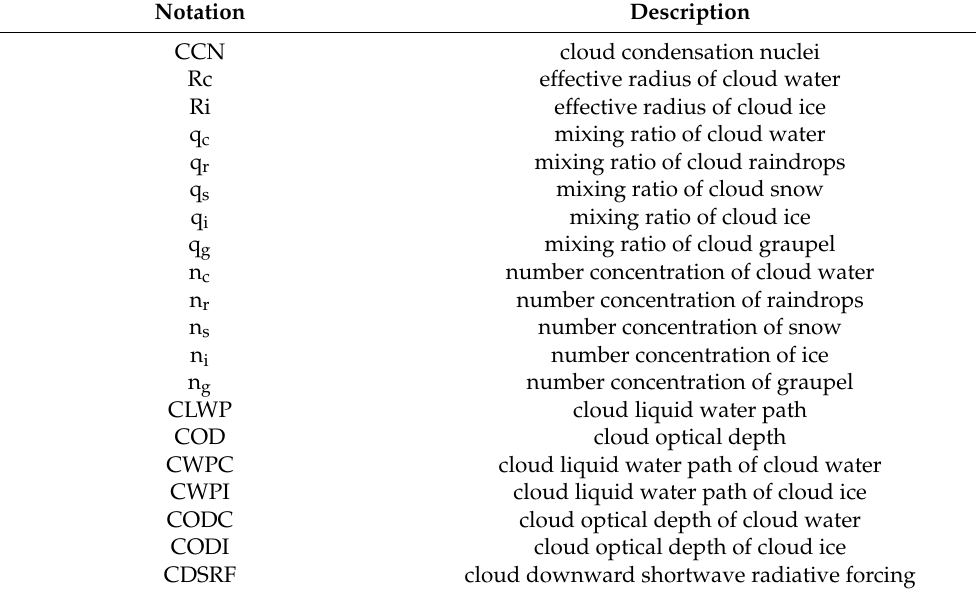
Table 1. List of the acronyms